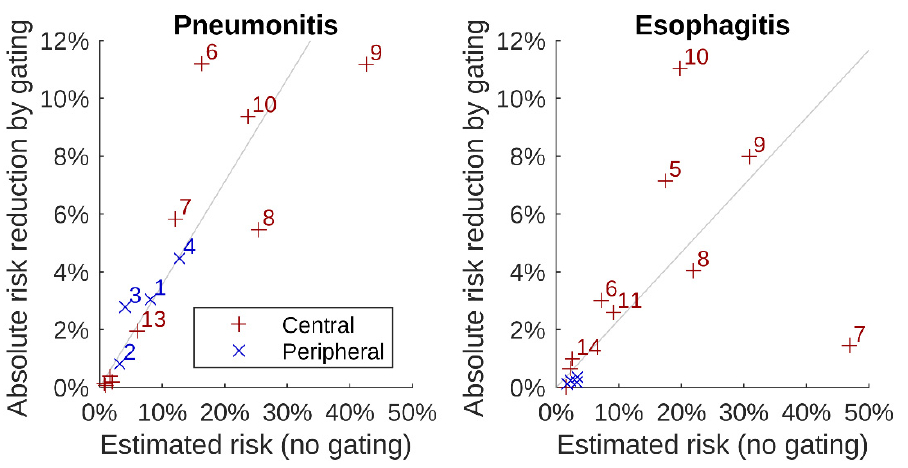
Figure 4. Absolute reduction in estimated radiation pneumonitis risk ( left ) and esophagitis risk ( right ) as a function of estimated risk of SBRT without gating. For the gating plans, a window of 40–60 was applied. Each symbol represents one patient case as indicated with numbers next to the symbol. Red color (+ symbols) indicates central tumors, and blue color (× symbols) indicates peripheral tumors. Grey lines indicate the mean risk reductions of 36% for pneumonitis and 23% for esophagitis.